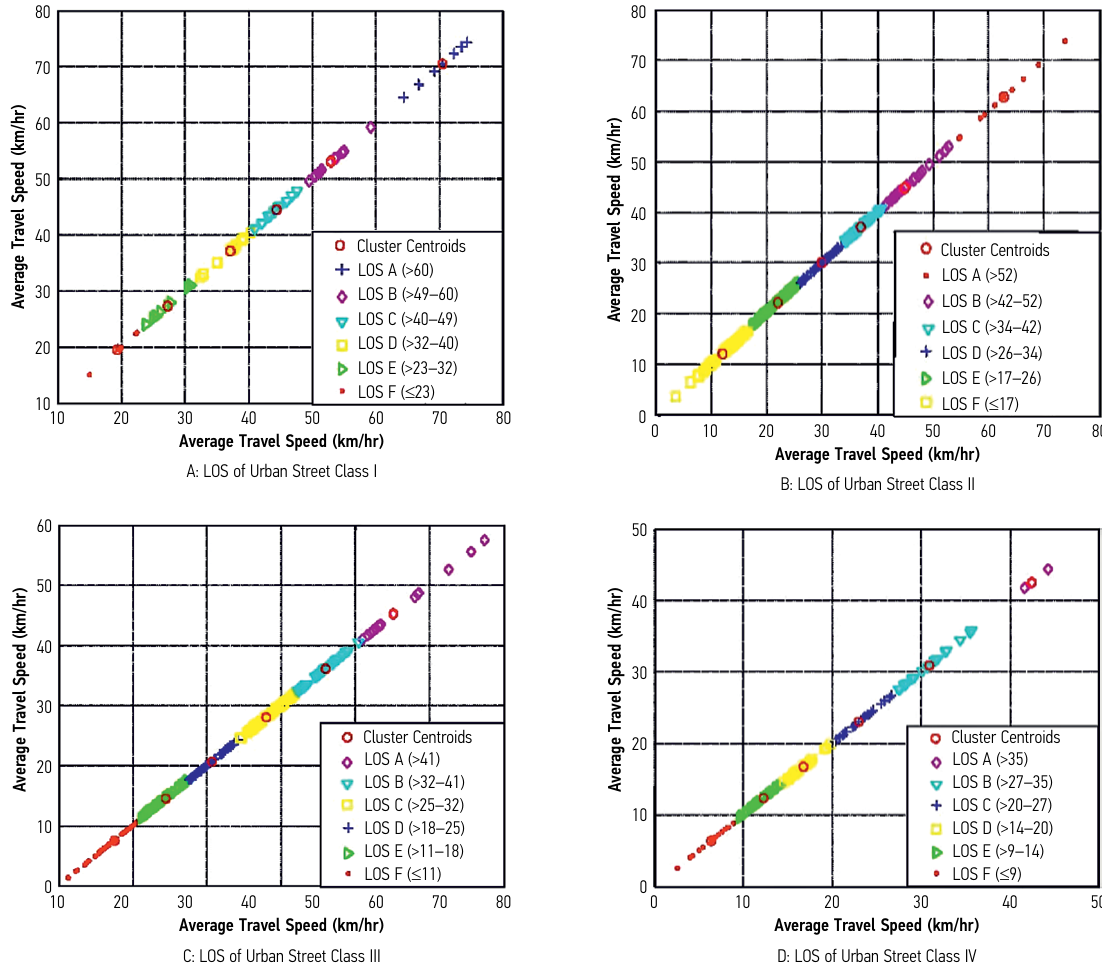
Fig. 3. k -medoid clustering of average travel speeds for LOS of urban street classes